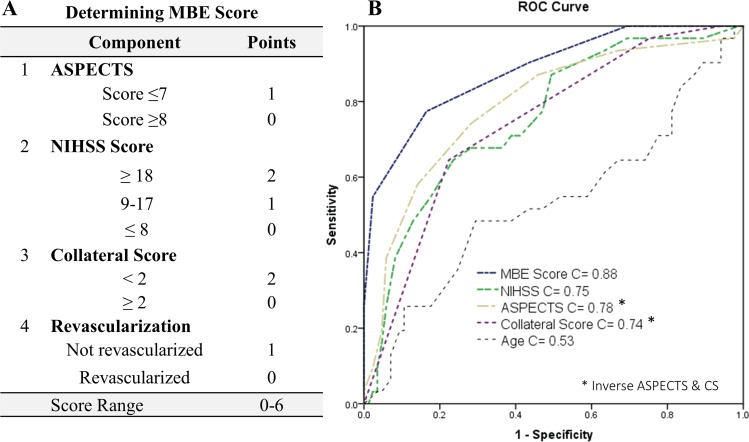
(A) MBE Scoring Components and Scores. (B) Receiver operator characteristics curve showing MBES in comparison with other clinical scores (NIHSS, ASPECTS, CS) that predict MBE. Age is shown for reference only.